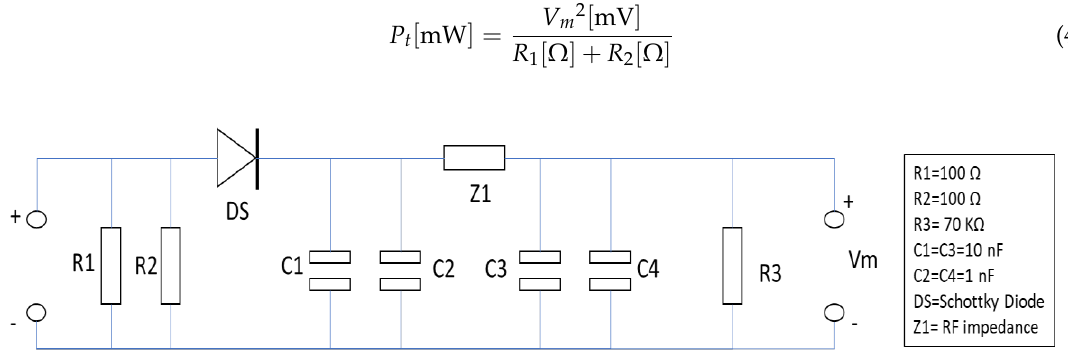
Figure 12. Probe circuit for the High-Power Amplifier (HPA) output measurement.